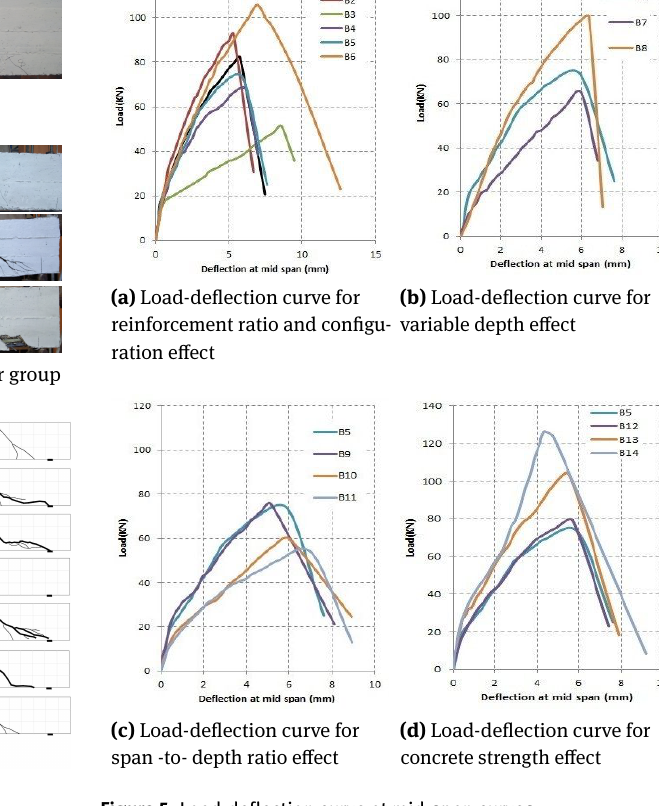
Figure 4: The crack patterns of tested specimens Figure 5: Load-deflection curve at mid-span